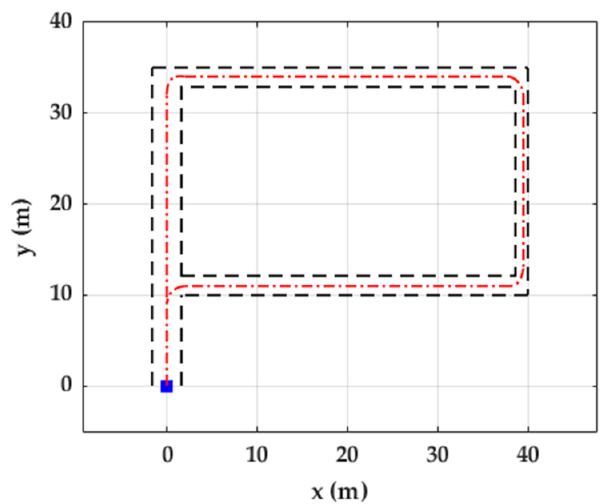
Figure 1. Illustration of the path used for walking, jogging and running in the Unicauca dataset. It is a “P” shaped path. The dotted red line represents the trajectory followed by one person, dotted black lines show outer edges (walls) of the path, and the blue square shows the start and end point of the trajectory.